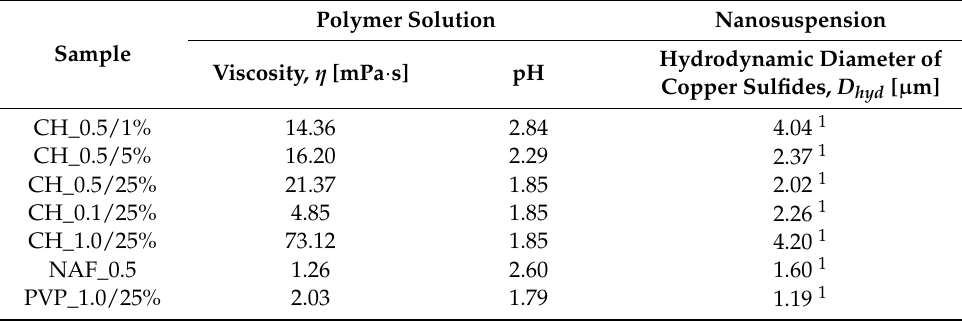
Table 2. Properties of the polymer solutions and